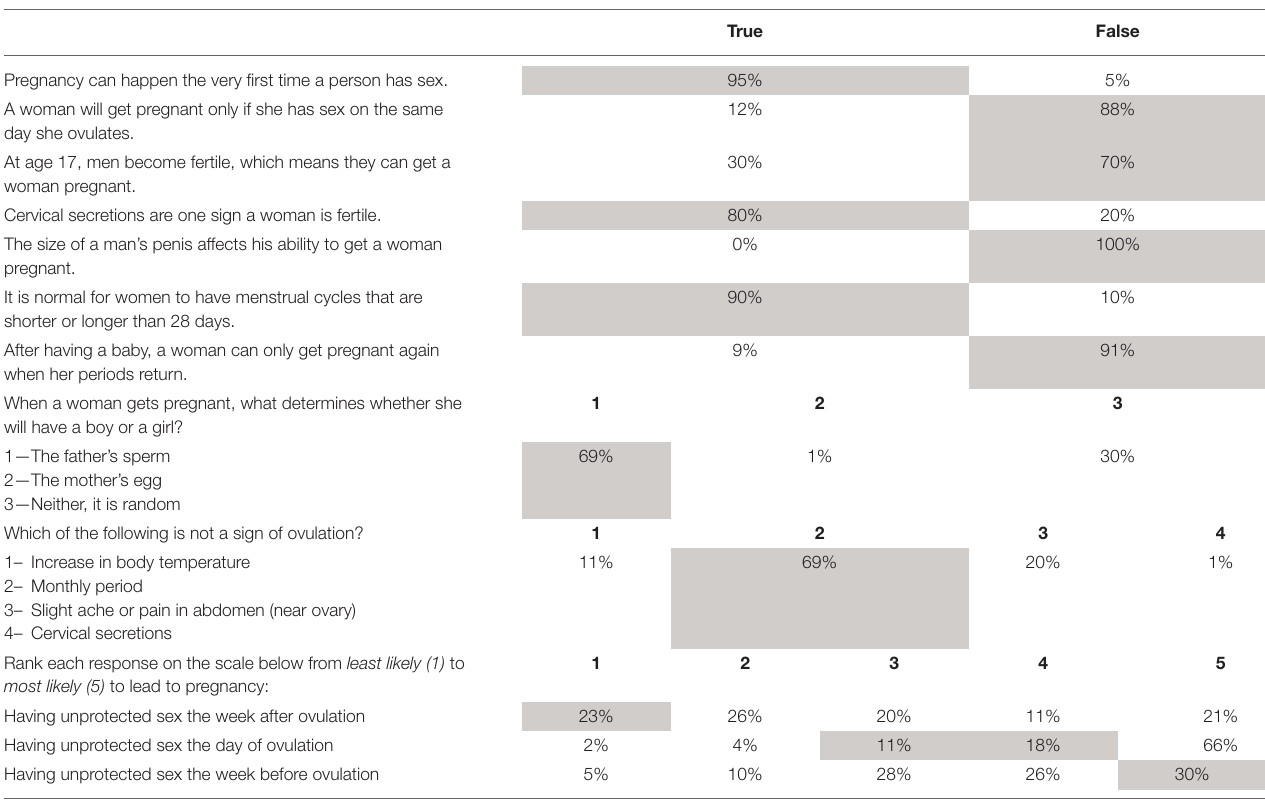
TABLE 2 | Responses to fertility awareness quiz.